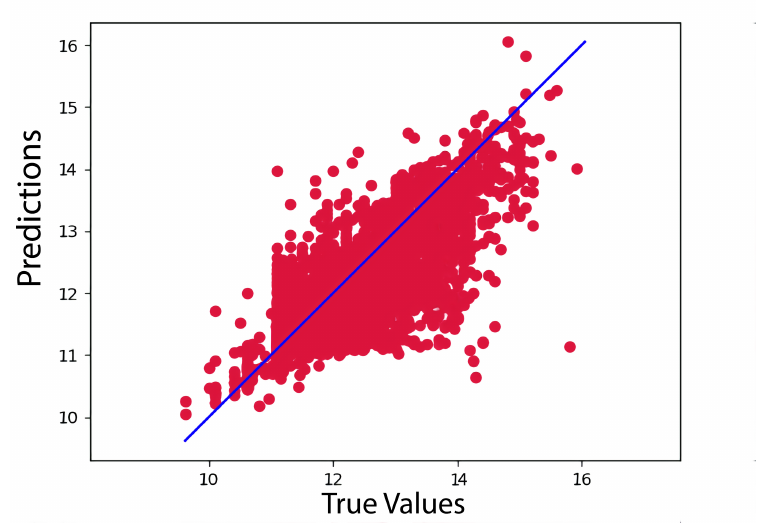
Figure 2. Predictions of the CSatDTA model vs. measured binding affinity values for